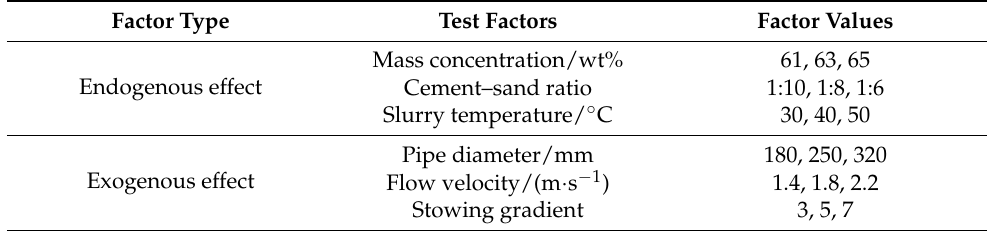
Table 5. Table 5. Experimental factor